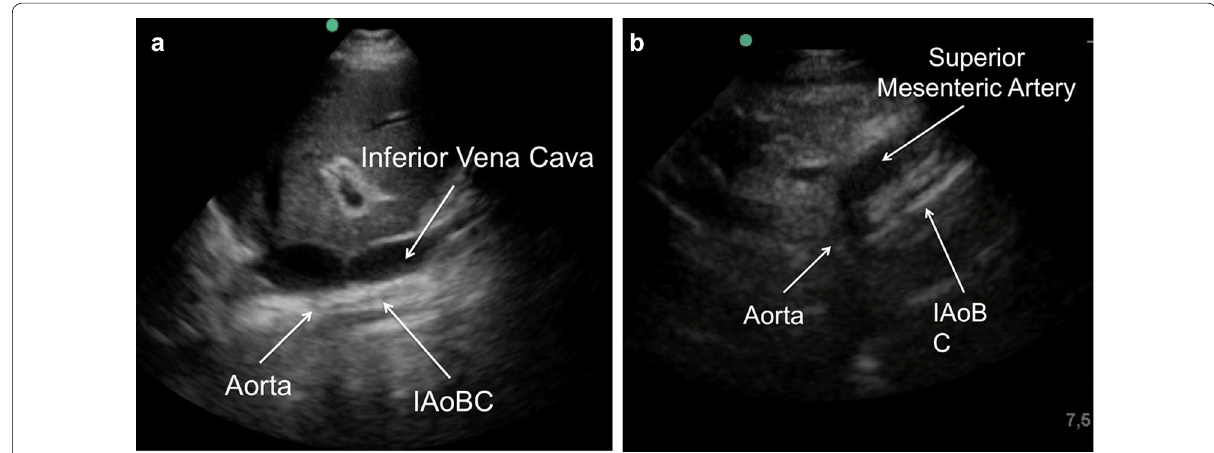
Fig. 6 a Right, transhepatic, longitudinal window (between the seventh and eighth intercostal space along the axillary midline) with a low-frequency transducer showing the inferior vena cava and the aorta with the functioning IAoBC. b Left paramedian longitudinal window to evaluate the exit of the abdominal vessels; in this case, we observe the IAoBC obstructing the superior mesenteric artery exit; thus, the IAoBC was advanced another 5 cm